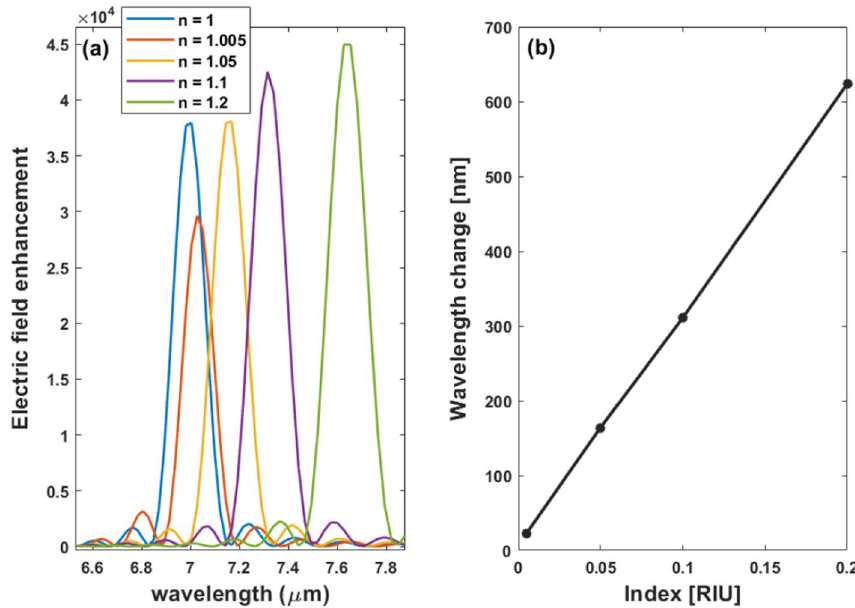
Figure 8. Electric field enhancement at the center of the gap ( x = 0, y = 0) versus wavelength for different medium refractive indices and ( b ) shows the resonance wavelength change with varying RI for the nanorod on the hybrid